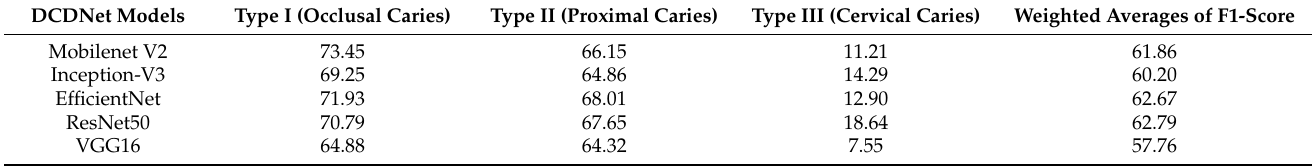
Table 3. F1-score results obtained with different backbone networks of DCDNet architecture (%).